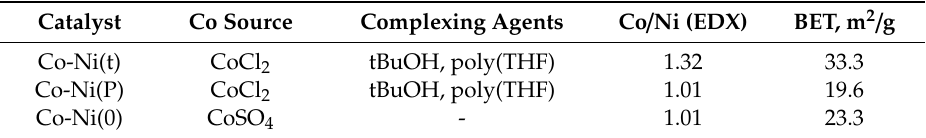
Table 1. Results of catalyst characterizations obtained by energy-dispersive X-ray spectroscopy (EDX) and nitrogen adsorption–desorption.